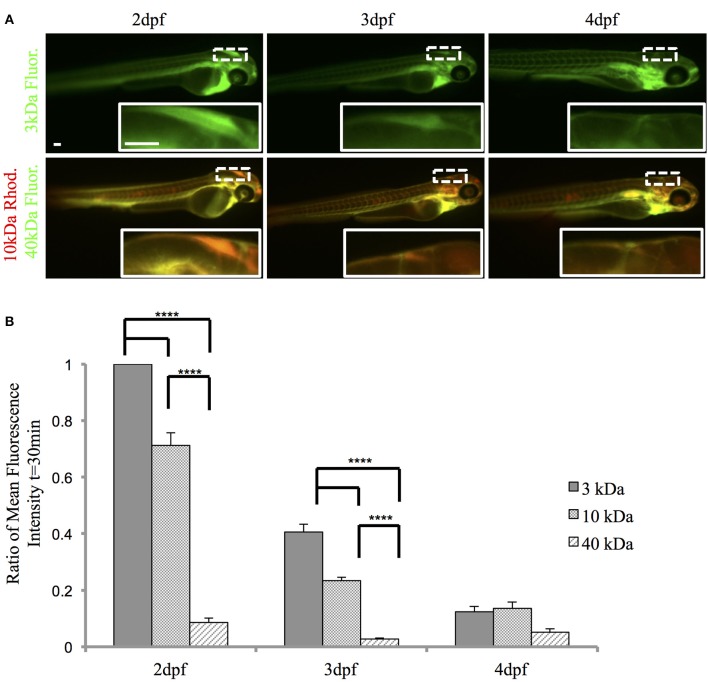
The zebrafish CP is functional and possesses size-selective properties. Casper zebrafish were intravenously injected with fluorescent tracers at 2, 3, and 4 dpf to identify tracer leakage from blood into the cerebrospinal fluid. (A) The top panel shows severe leakage of the 3-kDa fluorescein dextran into the brain ventricle (inset) at 2 dpf, minor leakage at 3 dpf, and little, if any, dextran penetration at 4 dpf. The bottom panel shows permeability of the 10-kDa rhodamine dextran at 2 dpf (inset), which decreases by 4 dpf. The 40-kDa fluorescein dextran was the least permeable at each developmental timepoint. Images were taken at 1 h post-injection. (B) A ratio of fluorescence intensity in the brain ventricle relative to the heart was measured at 30 min post-injection as a readout for tracer leakage into the brain ventricle. A One-Way ANOVA shows that the 3-kDa fluorescein dextran and the 10-kDa rhodamine dextran are significantly more permeable (i.e., greater mean fluorescence intensity) than the 40-kDa fluorescein dextran at 2 and 3 dpf. By 4 dpf, there was no significant difference in fluorescence intensity. Measurements are expressed as mean ± SE for n = 7; ****p < 0.0001. Abbreviations: Rhod, rhodamine dextran; Flour: fluorescein dextran. Scale bar is 50 μm.